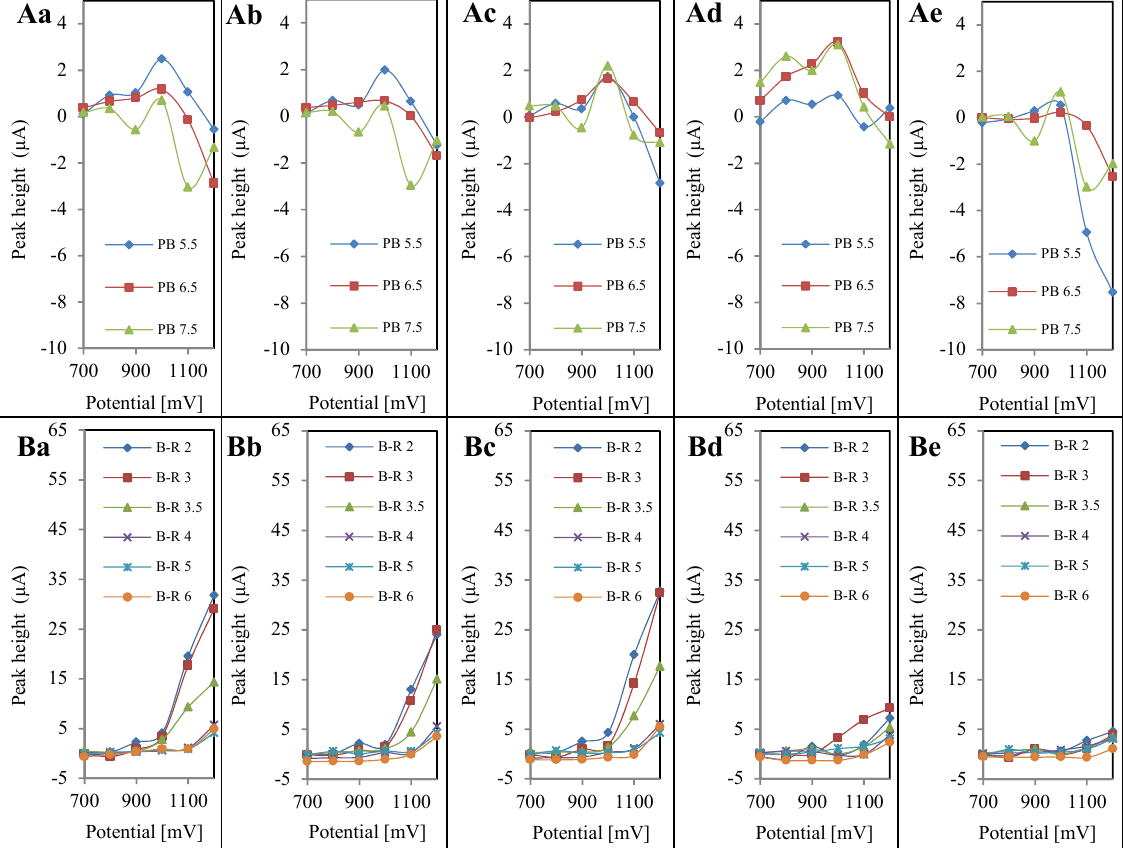
Figure 2. Hydrodynamic voltammograms (HDVs). All HDVs were measured with concentration of 10 µg.mL − 1 of PGEs using ( A ) phosphate buffer (PB) for ( Aa ) oxaliplatin; ( Ab ) cisplatin; ( Ac ), carboplatin; ( Ad ) PtCl (B-R) for ( Ba ) oxaliplatin; ( Bb ) cisplatin; ( Bc ) carboplatin; ( Bd ) PtCl